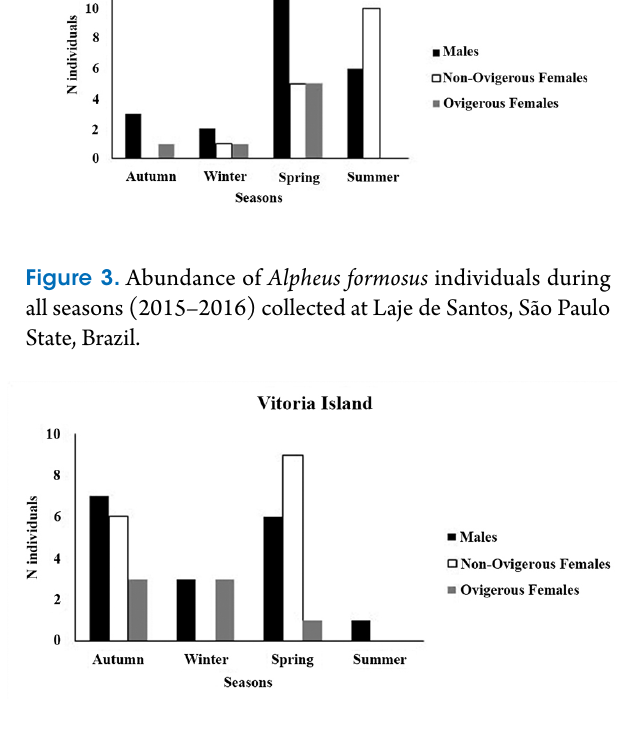
Figure 4. Abundance of Alpheus formosus individuals during all seasons (2015–2016) collected at Vitoria Island, São Paulo State, Brazil.